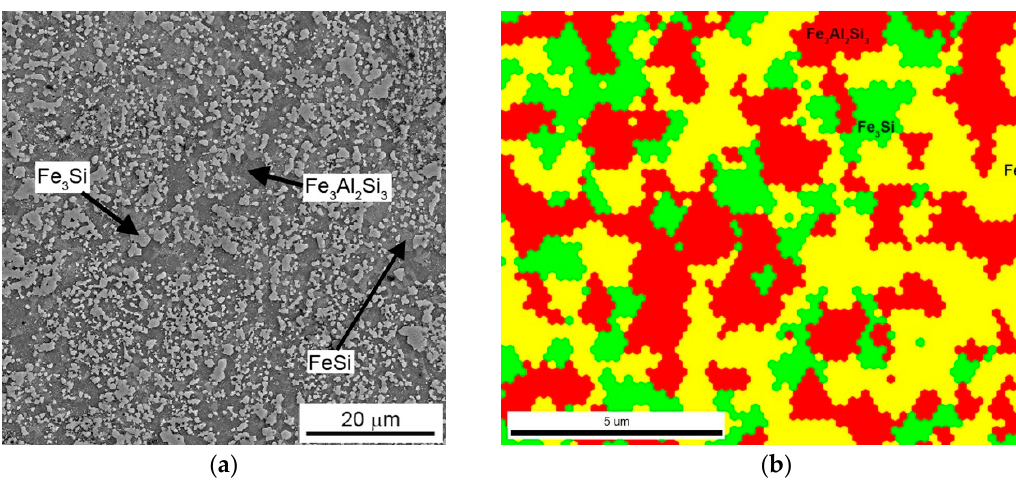
Figure 1. ( a ) Microstructure of FeAl20Si20 alloy produced by mechanical alloying and spark plasma sintering; ( b ) EBSD phase map of the alloy.